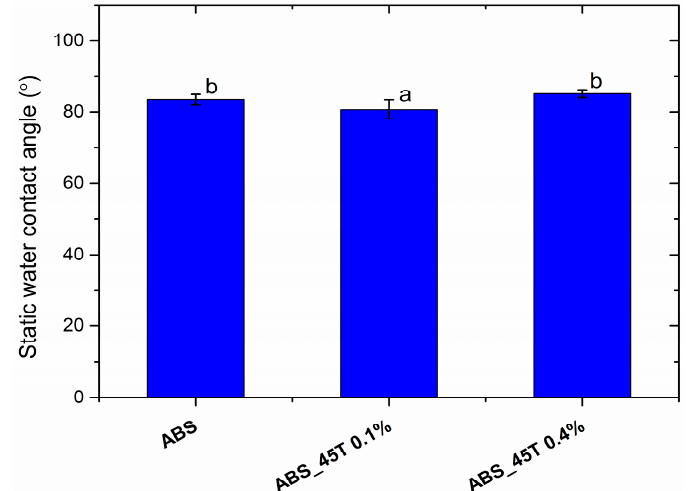
Figure 3. The static water contact angle of pure polymer and polymer containing 0.1% and 0.4% of silver nanoparticles AgNPs 45T by weight. Statistically significant differences ( p < 0.05) between the tested materials are marked a–b.